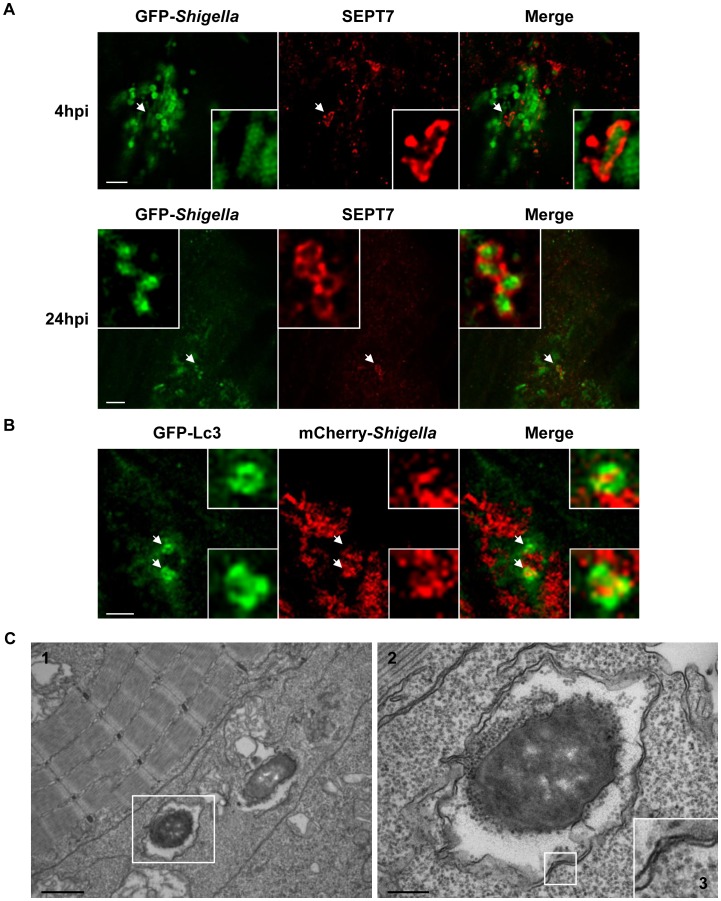

Shigella escape to the cytosol and induce septin caging and autophagy in zebrafish larvae in vivo.A. Zebrafish larvae were infected in the tail muscle with GFP-Shigella for 4 (medium dose) or 24 h (low dose), fixed, labeled with antibodies against SEPT7 (red) and to GFP (green) and imaged by confocal microscopy. Scale bar, 5 µm. B. GFP-Lc3 zebrafish larvae were infected with mCherry-Shigella for 4 (medium dose), fixed, labeled with antibodies against mCherry (red) and to GFP (green) and imaged by confocal microscopy. Scale bar, 5 µm. Shown here is an example of a GFP-Lc3 positive cell controlling bacterial replication (better than its neighbouring cells) 4 hpi. See also Video S8 for live imaging observations of GFP-Lc3 recruitment to Shigella. C. Cytosolic Shigella are sequestered in autophagosomes in vivo. Zebrafish larvae were infected in the tail muscle with GFP-Shigella for 4 h (medium dose) and fixed for electron microscopy. C2 is an expanded region of boxed region in C1 (i.e., autophagosome sequestering bacteria), C3 is an expanded region of boxed region in C2 (i.e., double membrane, a hallmark of autophagosomes). Scale bar, 1 µm (C1) or 0.25 µm (C2). See also Video S9 for a tilt series of Shigella autophagosomes in vivo.